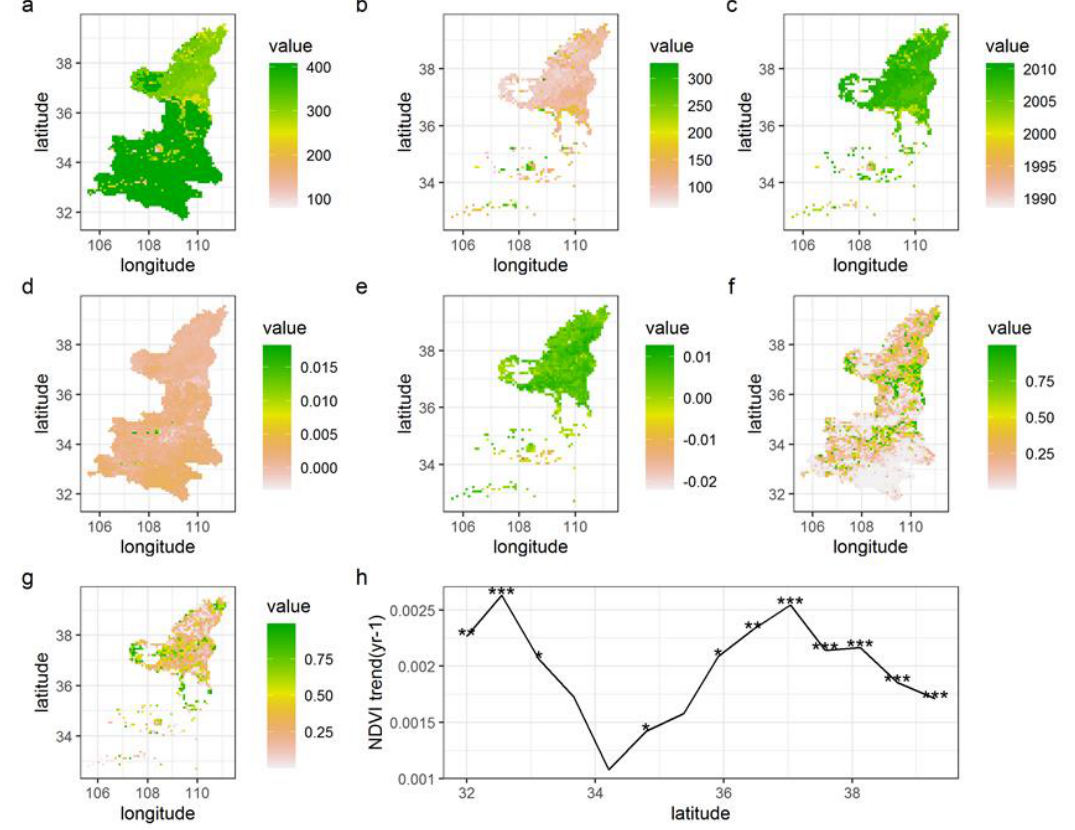
Figure 8. The trends and breakpoints on max NDVI time series from pixel scale ( a ): the length of the time series segments before the breakpoint (LSEG1); ( b ): the length of length of the time series segments after the breakpoint (SEG1); ( c ): breakpoints; ( d ): the slope of SEG1; ( e ): the slope of SEG2; ( f ): the p _value of the SEG1; ( g ): the p _value of SEG2; ( h ): latitudinal gradient of NDVI trends. *** p < 0.001; ** p < 0.01; * p < 0.05. The ‘latitude’ label on the axis represents north latitude, and the ‘longitude’ label on the axis represents the east longitude.).